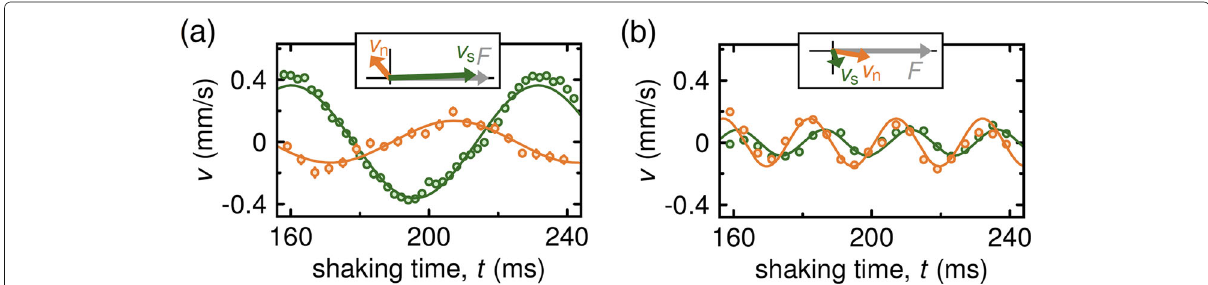
Fig. 19 Microscopic structure of the two sound modes at T / T c = 0.77. a Extracted v n (orange) and v s (green) for the second-sound resonance, exhibiting the out-of-phase motion anticipated for second sound. b Analogous results for the first-sound resonance. Adapted from Ref.